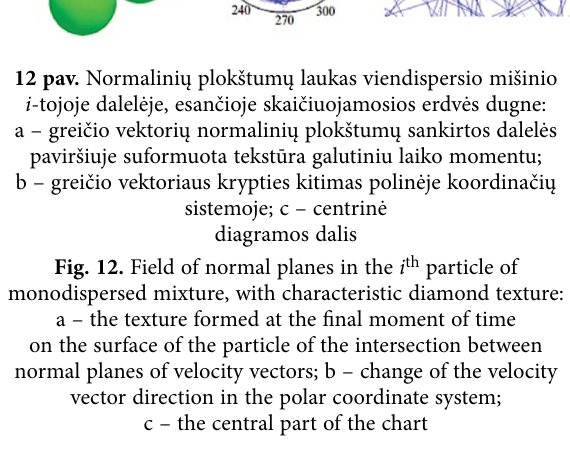
Fig. 11. Field of normal planes in the i th particle of the monodispersed mixture with characteristic texture of concentric circles: a – the texture formed at the final moment of time on the surface of the particle of the intersection between normal planes of velocity vectors; b – change of the velocity vector direction in the polar coordinate